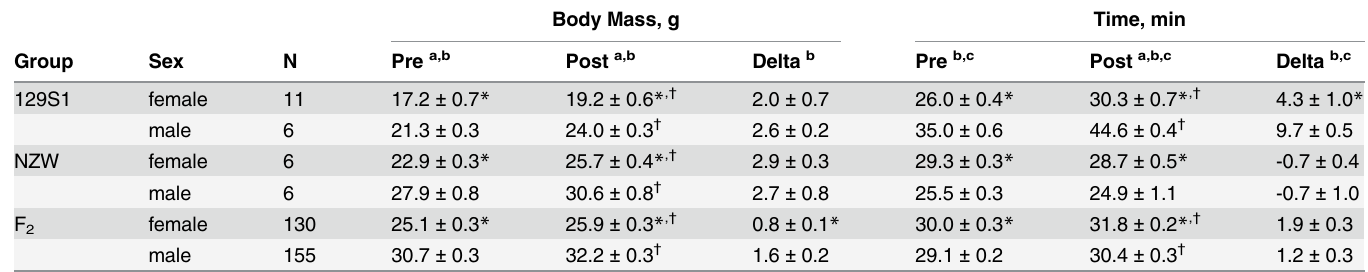
Table 1. Body mass and exercise time in inbred parental and F 2